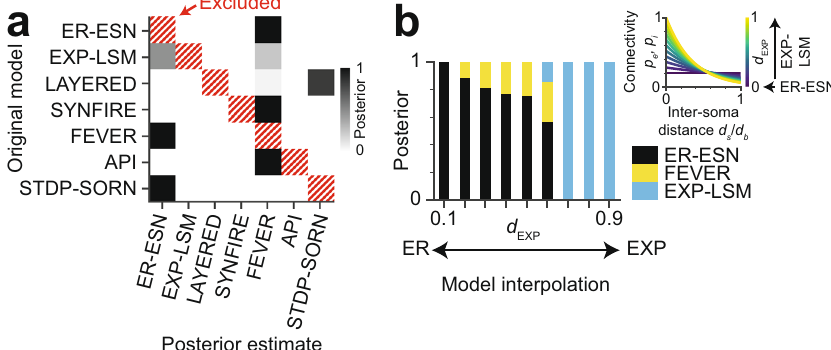
Fig. 6 Effect of incomplete hypothesis space and of model interpolation on Bayesian model selection. a Confusion matrix reporting the posterior distribution when excluding the true model (hatched) from the set of tested model hypotheses ( n = 1 repetition). Note that posterior probability is non- uniformly distributed and concentrated at plausibly similar models even when the true model is not part of the hypothesis space. b Posterior distributions for connectome models interpolated between ER-ESN and EXP-LSM ( n = 1 repetition per bar). Inset: Space constant d EXP acts as interpolation parameter between ER-ESN ( d EXP = 0) and EXP-LSM ( d EXP = 1). Note that the transition between the two models is captured by the estimated model posterior, with an intermediate (non-dominant) confusion with the FEVER model.